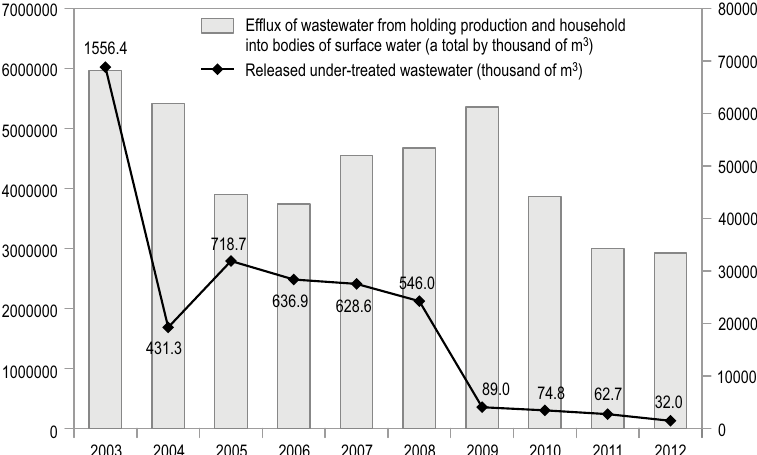
Fig. 8. The results of the analysis on the normally treated wastewaters releases into surface waters in the districts of Lithuania during the period